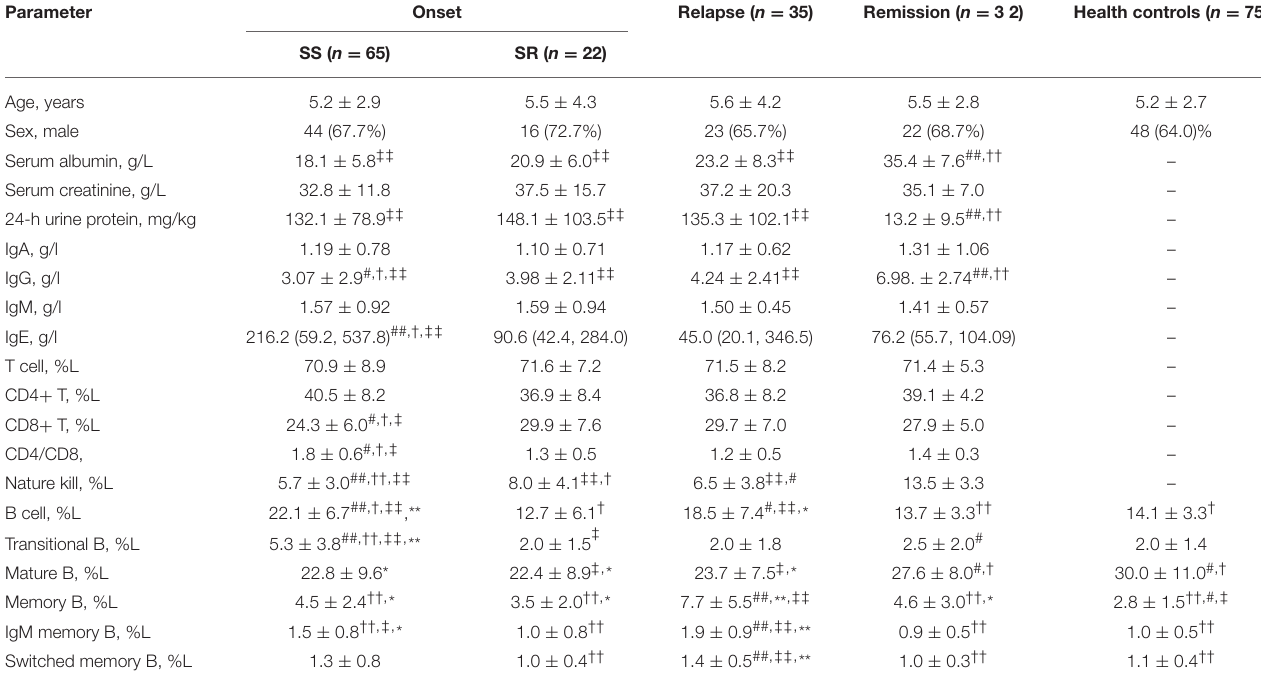
TABLE 1 | Characteristics of patients with nephrotic syndrome and controls.